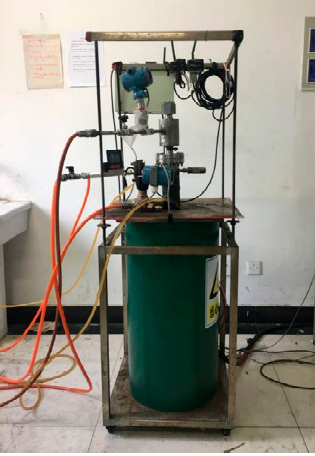
Figure 2. Experimental device.